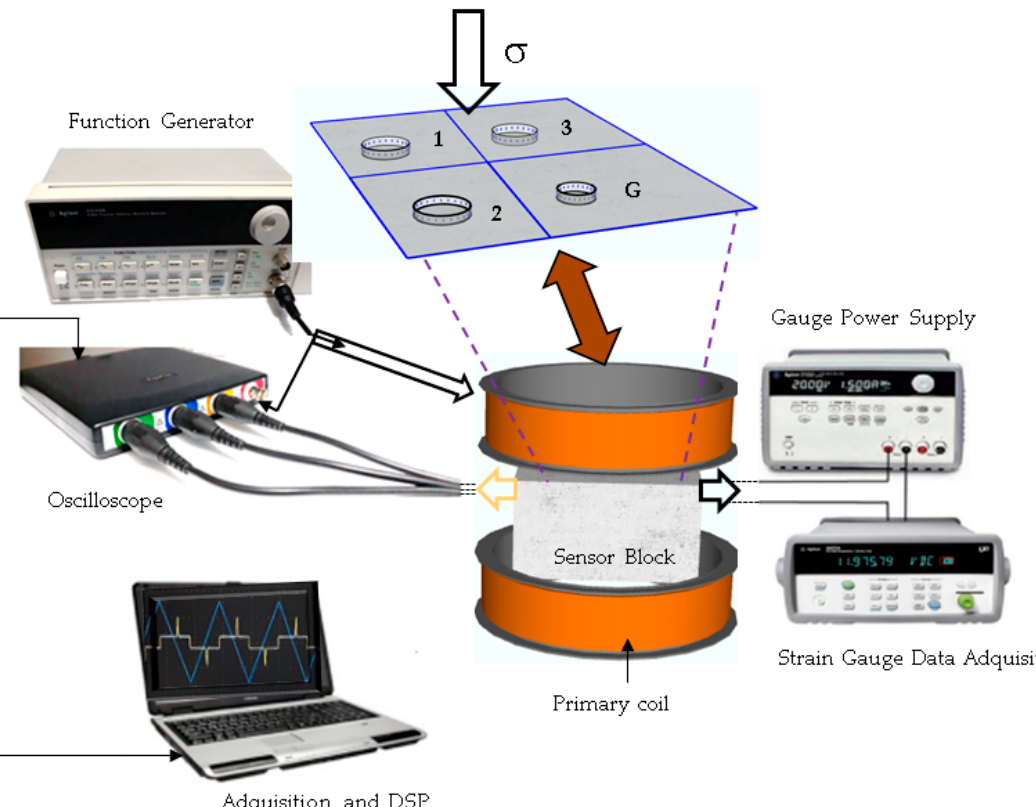
Figure 3. Induction method of the switching field measurement used for the